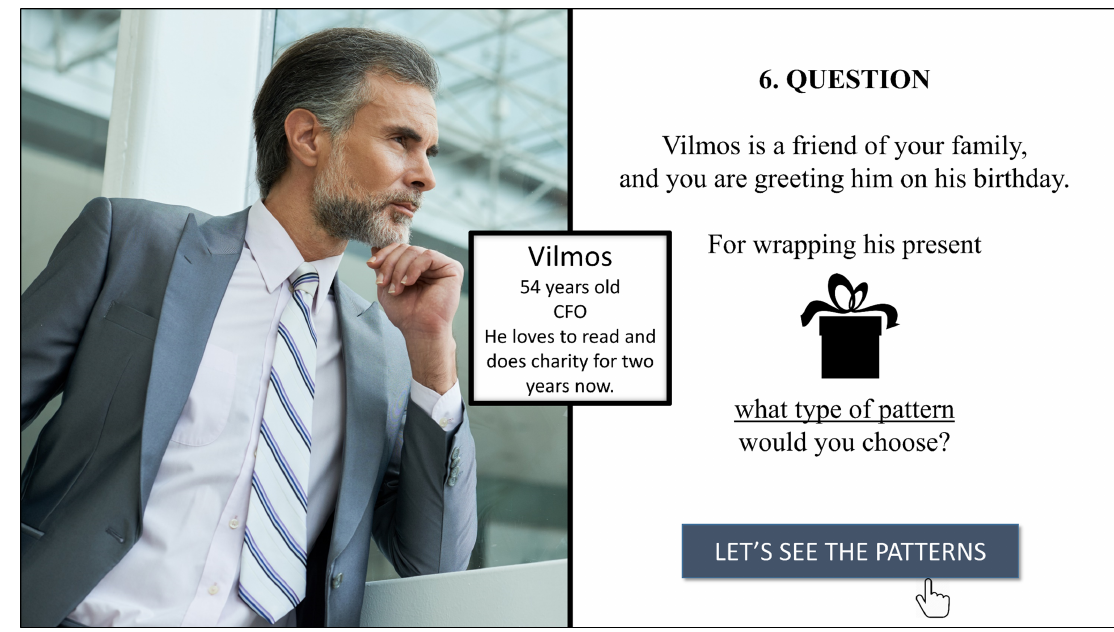
Figure 20. Personalized mood of Elegant-Classic-Masculine.